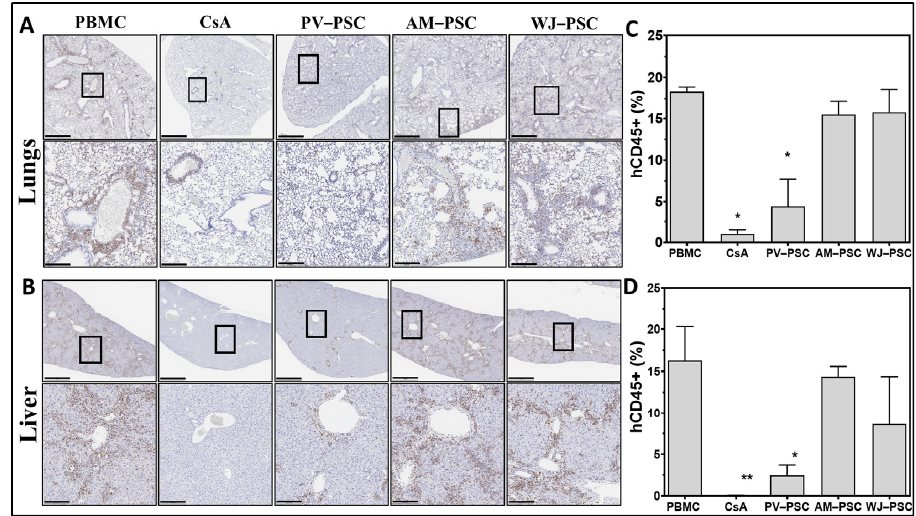
Figure 4. PL-PSC preferentially diminishes human CD45+ cell infiltration in the lungs and liver of GvHD mice as compared with amnion or Wharton’s jelly PSCs. Representative histological images of mice lung ( A ) and liver ( B ) tissues stained for human CD45+ cells. Fibrotic pathological scoring of lung fibrosis performed by the Ashcroft score ( C ) and, liver fibrosis by the Ishak score ( D ). Statistical analysis is represented by a one-way ANOVA with Dunnet’s post hoc test. * p < 0.05, ** p < 0.001, n = 3. Upper row scale = 1 mm; lower row scale = 200 µm. Abbreviations: human peripheral blood mononucleated cells (huPBMC), human perinatal stromal cells (huPSCs), amniotic perinatal stromal cells (AM-PSC), placental villi perinatal stromal cells (PV-PSC) and Wharton’s jelly perinatal stromal cells (WJ-PSC).